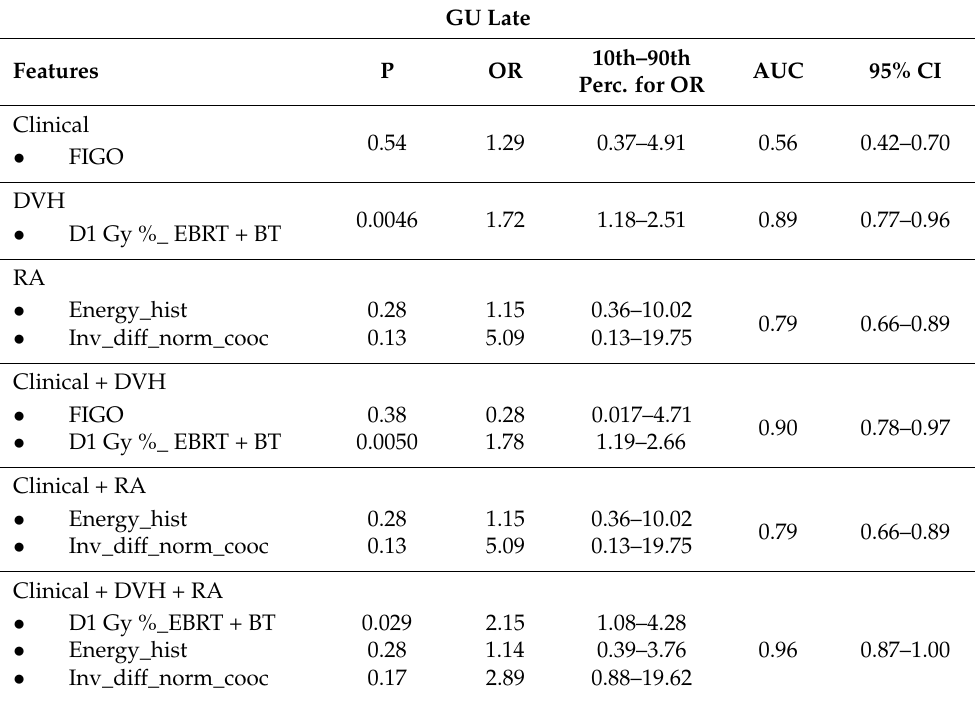
Table 5. Results of the multivariate logistic analysis for late genitourinary toxicity.